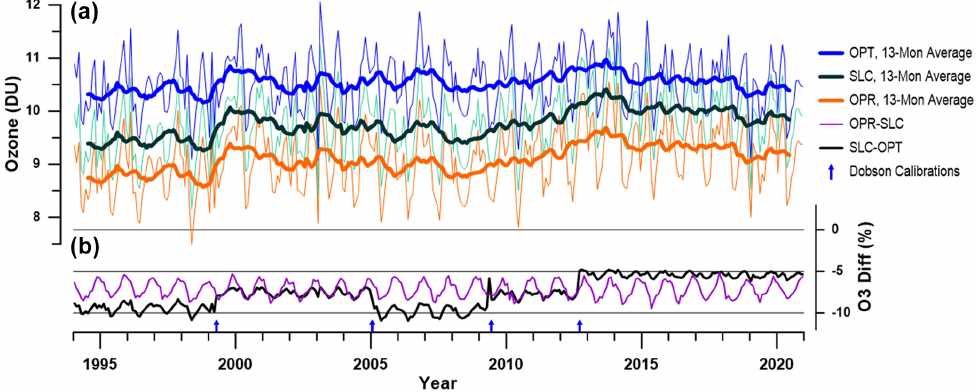
Figure 4. (a) The time series of Umkehr monthly averaged (thin lines) ozone in layer 8 (4–2hPa) compared with operational (OPR), standard stray light corrected (SLC), and optimized (OPT) versions. The thick lines are a 13-month running average. (b) A difference between OPT and SLC (black line) and between OPR and SLC data (purple